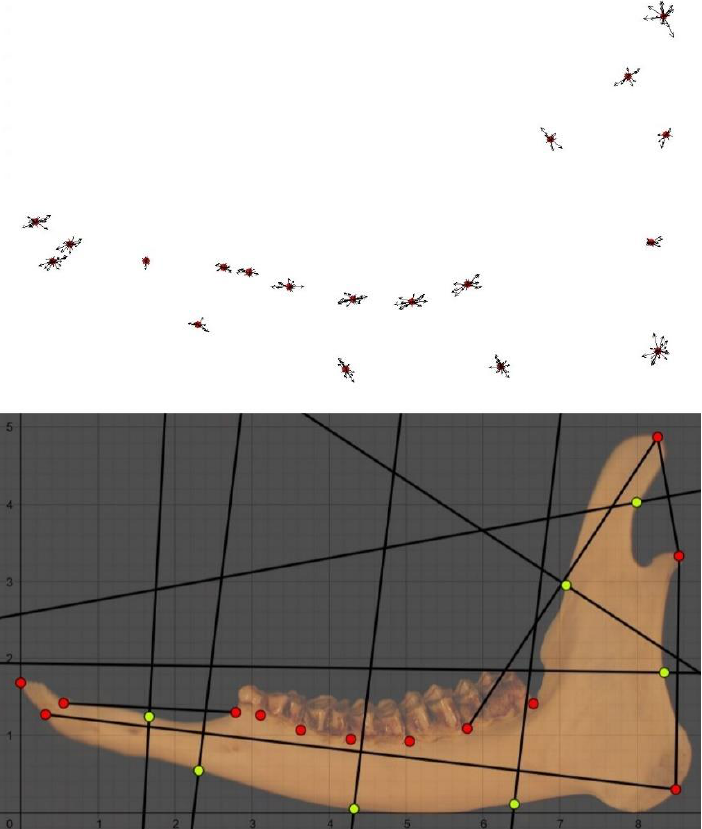
Figure 3. On the top: the consensus configuration for the lateral side of the mandible (aged 0 – 8 months). On the bottom: the caption of the lateral side of the mandible (aged 0 – 8 months) from Geogebra. Landmarks are shown in red dots, while semi-landmarks are shown in yellow. Semi-landmarks were placed on the anatomical part encountered by the axis perpendicular to the midpoint of the segment connecting two landmarks.